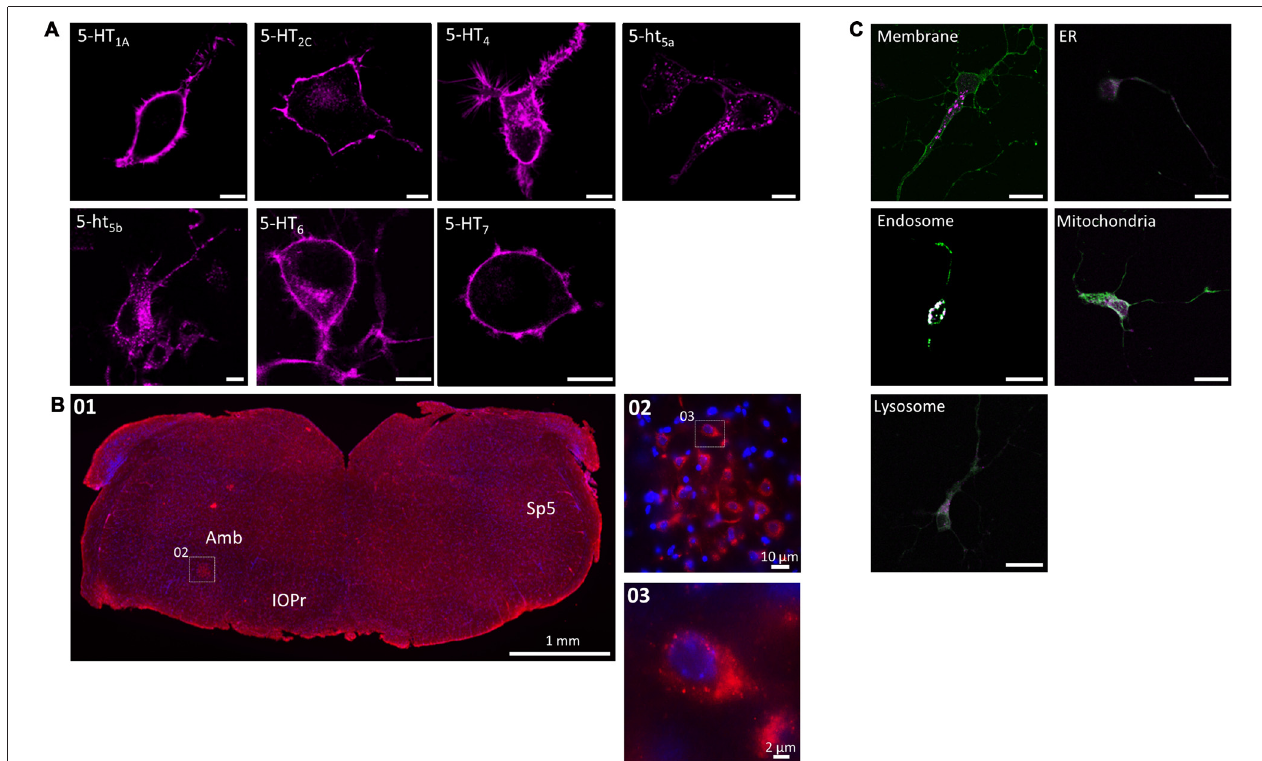
FIGURE 1 | Subcellular localization of serotonin (5-HT) receptors in vitro and in vivo . (A) When expressed recombinantly in N1E-115 cells, 5-HT 1A / 2C / 4 / 6 / 7 produce a clear membrane staining. In contrast, 5-ht 5a / 5b produce a distinct intracellular staining with weak (5-ht 5a ) or no (5-ht 5b ) membrane staining. Artificially truncating the other 5-HT receptors (here shown exemplarily for 5-HT 7 ) produces the same intracellular pattern observed for 5-ht 5a / 5b . Scale bars represent 10 µ m. (B) The intracellular localization of 5-ht 5b is not an artifact of recombinant expression, but can be visualized in vivo . Immunohistological staining of murine brainstem (01) from hemizygous Mecp + / − mice against 5-ht 5b (see “Materials and Methods” Section) reveals upon magnification (02) the same clustered intracellular localization (03) as seen in cells. Scale bars as indicated. Bregma is ∼ − 6.5. Abbreviations: Amb, Nucleus ambiguus; IOPr, inferior olive, principal nucleus; Sp5, spinal trigeminal tract. (C) Co-localization of 5-HT receptor 5-ht 5b (purple) with cellular compartment markers (green) in primary hippocampal neurons. Neurons between DIV 9 to DIV 11 were transfected with fluorescently labeled 5-HT receptor 5-ht 5b and compartment markers for membrane (GAP-43), endoplasmic reticulum (ER;